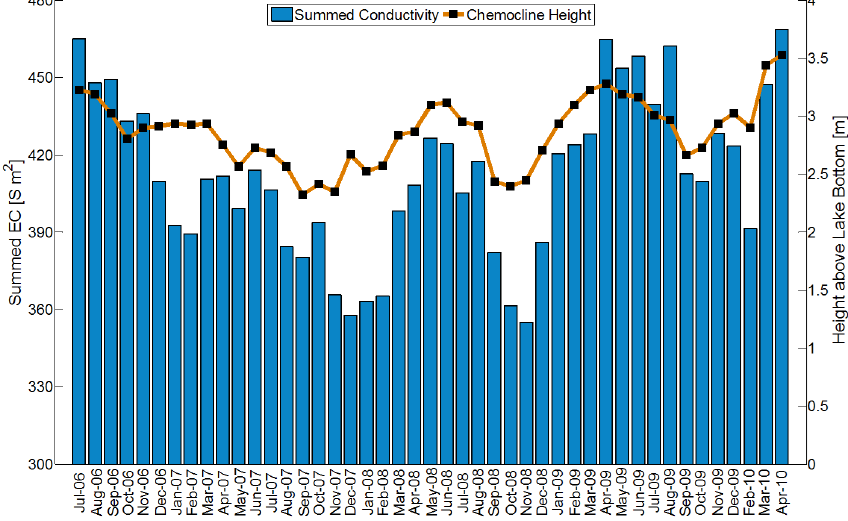
Figure 7. Time series of chemocline height and summed conductivity at Waldsee between July 2006 and April